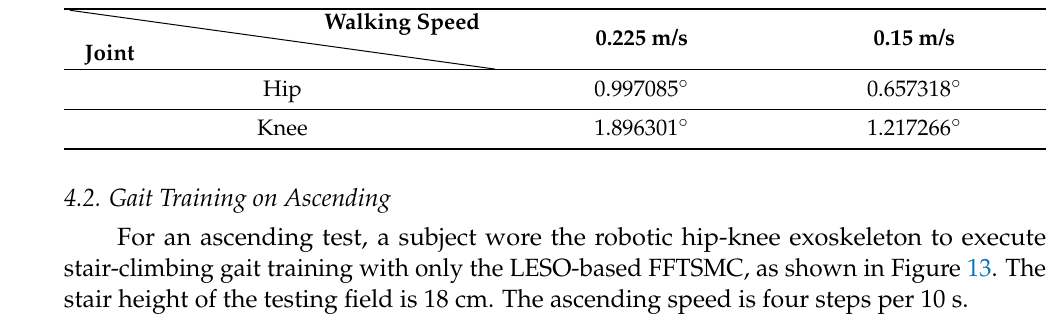
Figure 12. Trajectories of knee joint by LESO-based FFTSMC at walking speed = 0.15 m/s.